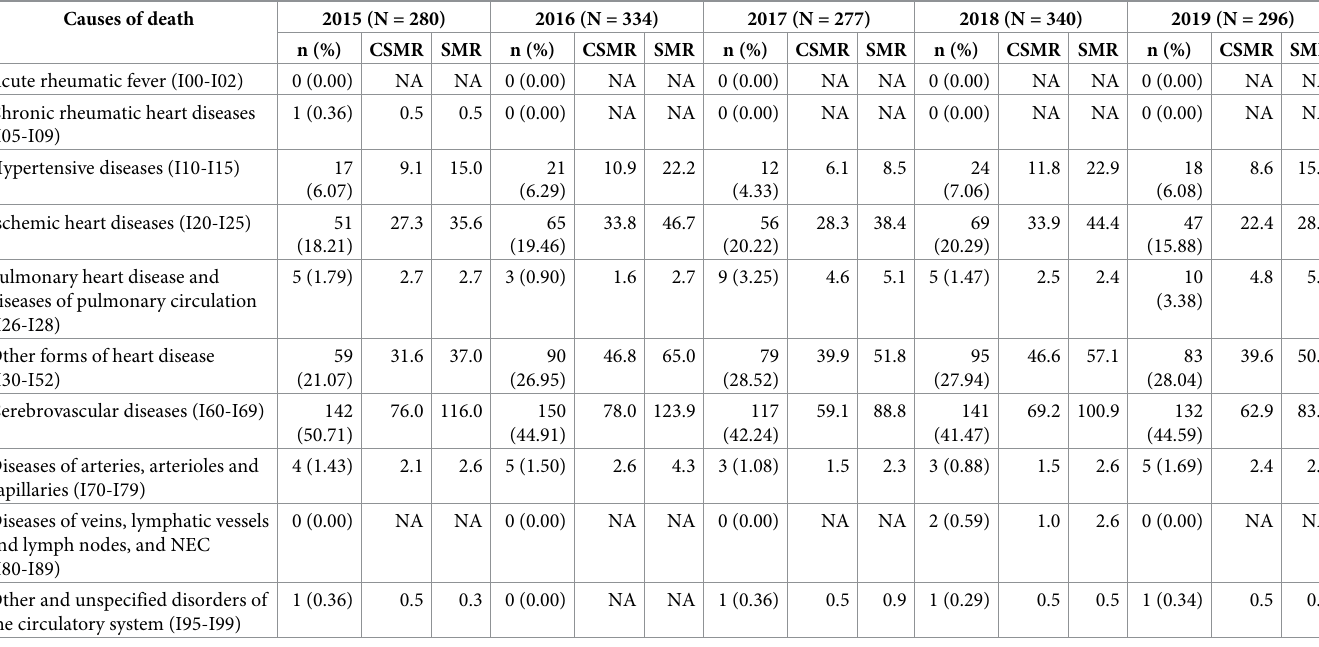
Table 5. Causes of death among people with intellectual disabilities by ICD-10-based diseases of the circulatory system from 2015 to 2019. Causes of